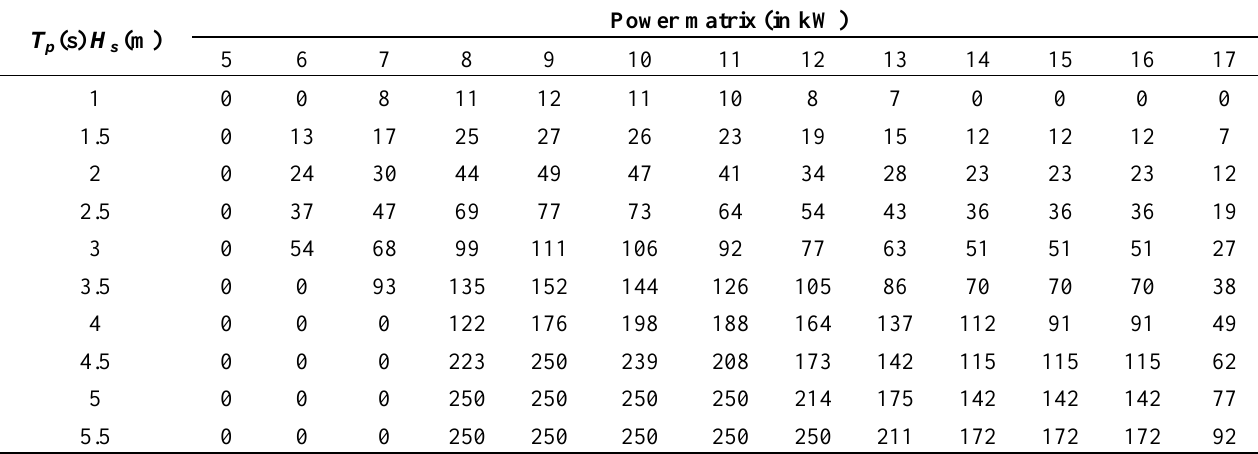
Table A1. Power matrix (in kW) for the wave energy converter Aqua